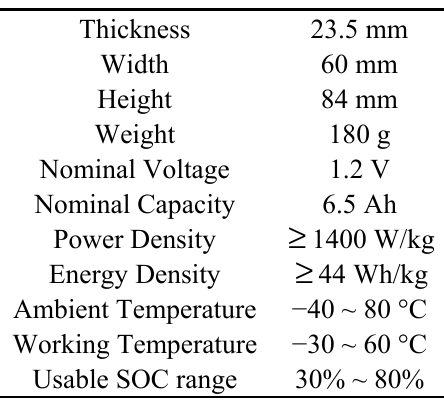
Table 4. Cell dimensions and main electrical specifications.